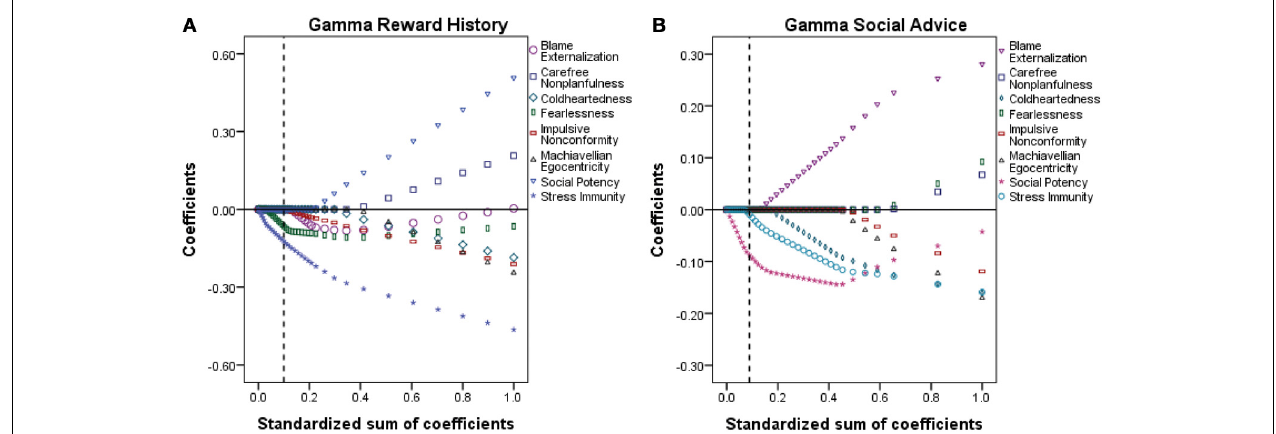
FIGURE 3 | Results of the variable selection procedure for γ reward history (A) and γ social (B). The maximum standardized sum of coefficients (SSC; x-axis) was set at 1.0, representing 100% of the contribution of the PPI scales to the corresponding γ parameter. Each sub-figure should be read from right